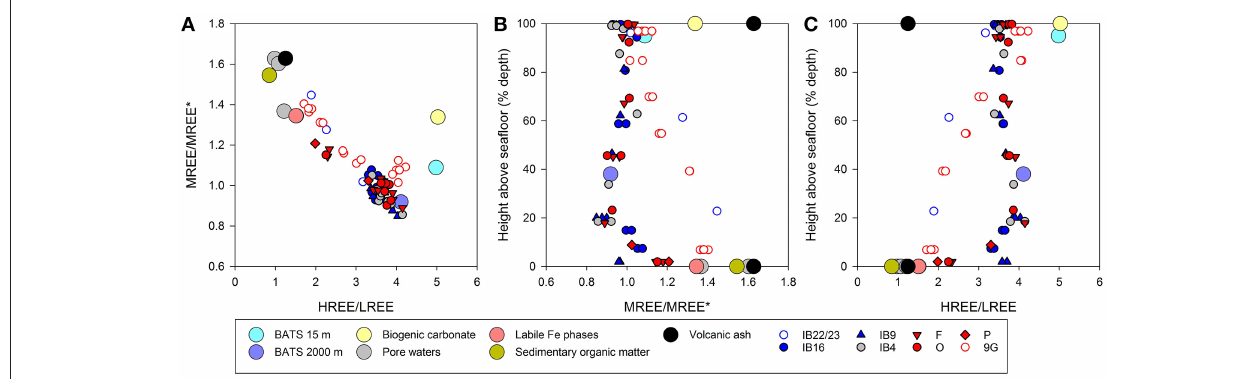
FIGURE 8 | (A) The PAAS normalised REE concentrations presented as the MREE anomaly (MREE/MREE* = (Gd + Tb + Dy)/[(La + Pr + Nd + Tm + Yb + Lu)/2]) vs. the HREE/LREE ratio ([Tm + Yb + Lu]/[La + Pr + Nd]). Sample depth presented as height above seafloor as a % of the water column depth vs. (B) MREE/MREE* and (C) HREE/LREE. The REE source data (large circles) are collated REE concentrations representing different potential sources of REE in the marine environment, both solid and aqueous phases: Bermuda Atlantic Time Series (BATS) reference seawater from 15m and 2000m water depths (van de Flierdt et al., 2012), biogenic carbonate from warm water corals in the North Atlantic (Sholkovitz and Shen, 1995), marine sedimentary pore waters collected in the Northeast Pacific along the Oregon margin, from cores in a depth transect ( Abbott et al., 2015b), labile Fe phases (Bayon et al., 2004; Gutjahr et al., 2007; Du et al., 2016), sedimentary organic matter (Freslon et al., 2014), Icelandic ash (Tepe and Bau, 2014). Details of average values used in this study are in Table S3. The pore water data (Abbott et al., 2015b) represent the average REE concentrations in pore waters of the top 5cm of sediment from cores HH200, HH500, HH1200, and HH3000, corresponding to water column depths of 202, 500, 1,216, and 3,060m respectively. The depth-related differences in pore water MREE/MREE* and HREE/LREE are more clearly seen in Figure 10 . To note, surface waters from O and all 9G samples were not